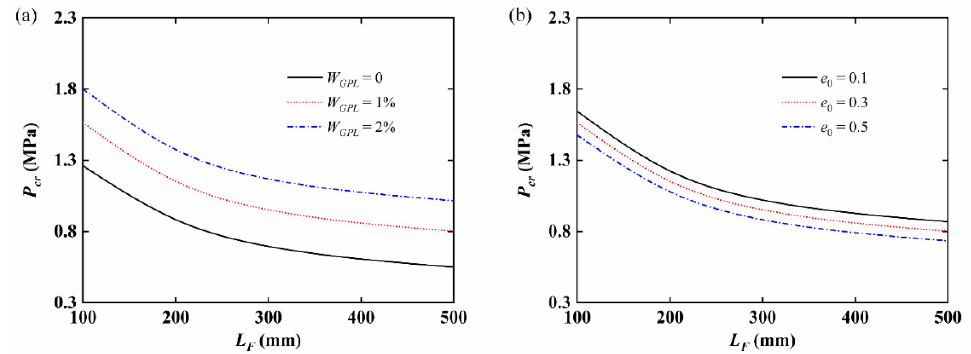
Figure 13. Variations in critical pressure of ring-stiffened porous GPLRC cylindrical shells with ring-stiffener spacing for different ( a ) weight fractions and ( b ) porosity coefficients.